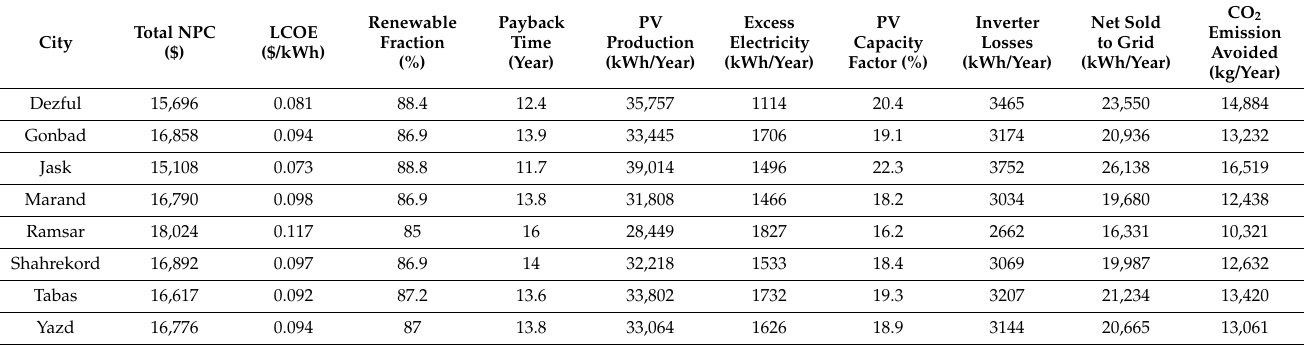
Table 5. Results of slope 30 ◦ .